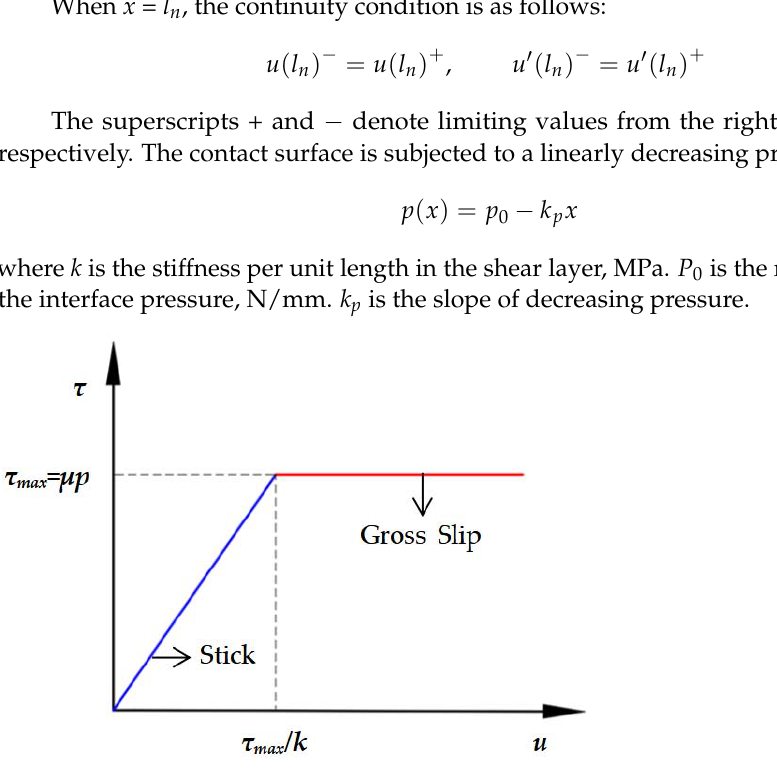
Figure 5. Relationship between the force and displacement of the shear layer.